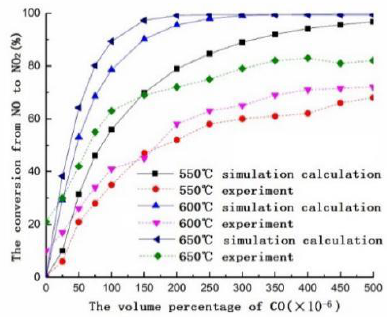
Figure 7. Effect of CO concentration on the conversion.